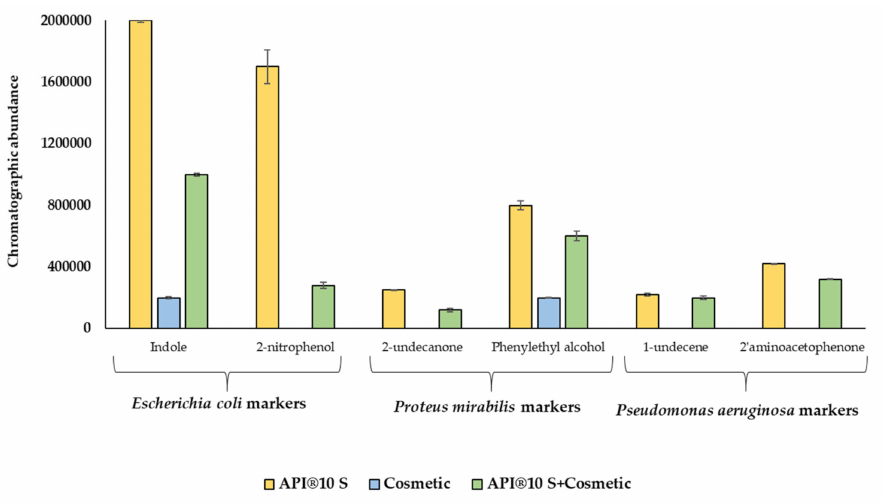
Figure 8. Influence of substrate in the MVOCs’